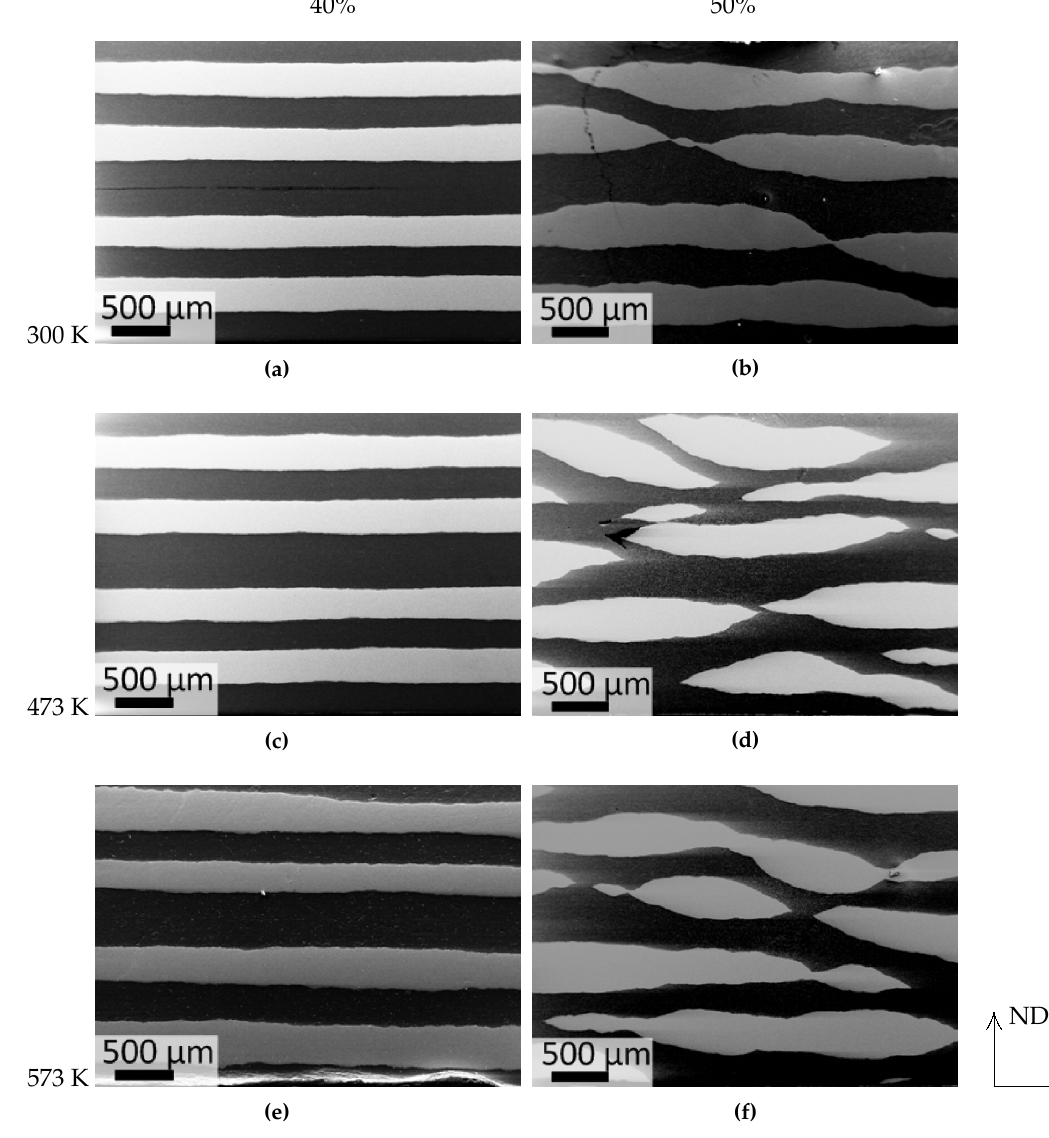
Figure 9. SEM micrographs showing the layer structure of a five-layered composite roll bonded with a single ARB cycle at elevated temperatures. The sheets are rolled with a 40% ( a , c , e ) or a 50% ( b , d , f ) thickness reduction during the second